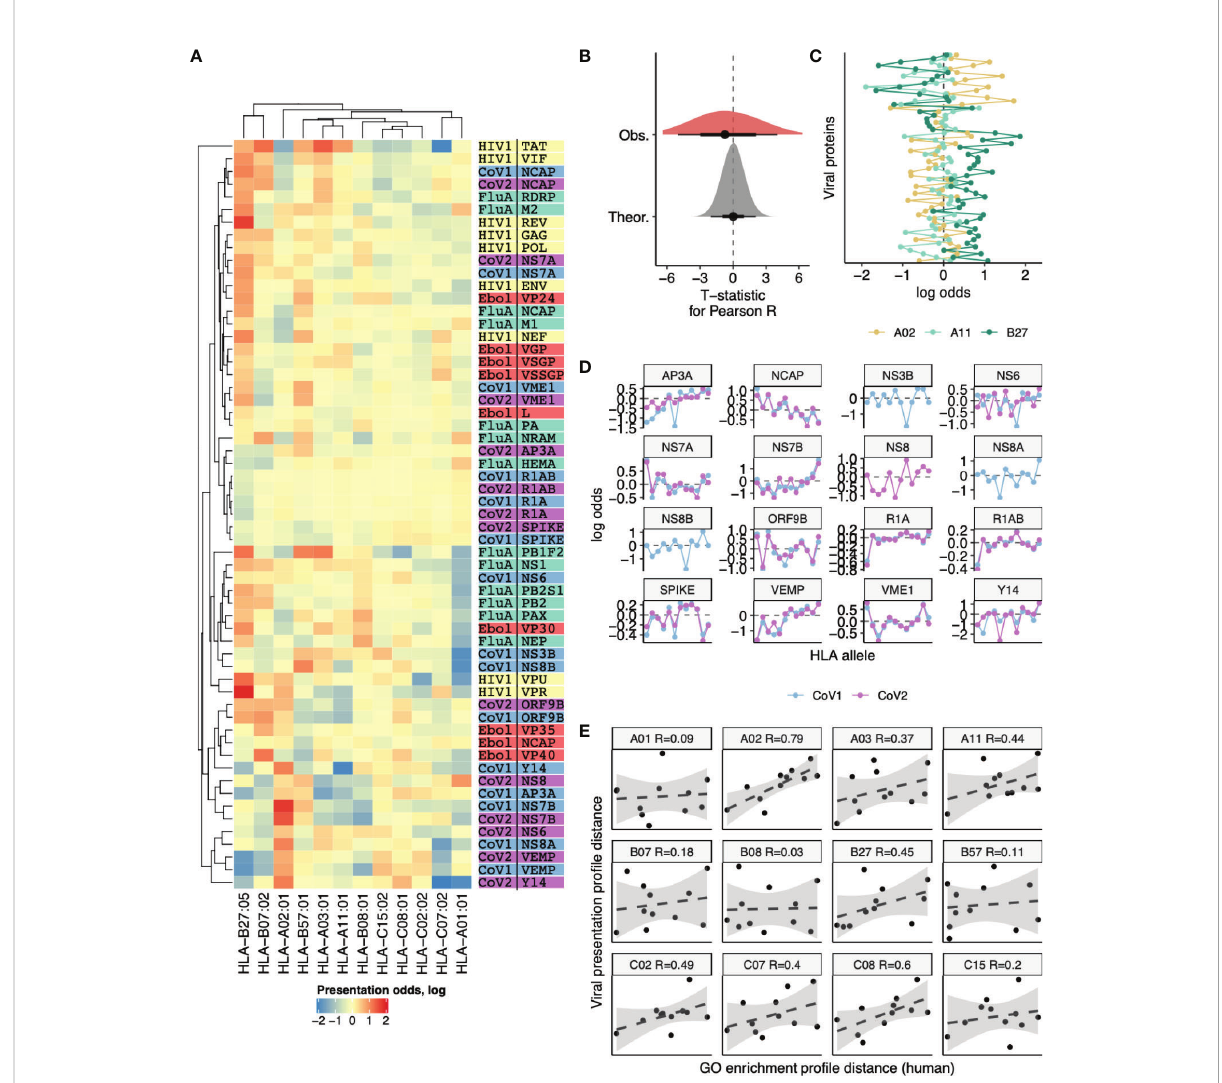
FIGURE 6 Differences in the number of ligands coming from viral genes presented by 12 different HLA alleles. (A) Heatmap showing the logarithm of the ratio of observed to expected number of HLA ligands (presentation odds). Expected number of ligands for each gene and HLA pair was estimated as the sum of corresponding row and column of the matrix divided by the total number of ligands in the matrix. Dendrograms show results of hierarchical clustering of gene-wise and HLA-wise presentation pro fi les performed using complete linkage algorithm with Euclidean distance measure. Proteins from HIV (yellow), In fl uenza (green), Ebola (red), SARS-CoV-1 (blue) and SARS-CoV-2 (purple) are shown. (B) Absolute values of T-statistic for observed pairwise correlation coef fi cients between viral gene presentation pro fi les of different HLAs (dark grey) compared to theoretical distribution (n=1000 random samples from null distribution with same number of degrees of freedom, light grey). (C) An example comparison of viral gene presentation pro fi les between HLA-A*02:01, HLA-A*11:01 and HLA-B*27:05 alleles. (D) Comparison of SARS-CoV-1 and SARS-CoV-2 protein presentation odds across different HLA alleles. (E) Correlation between distance in viral protein presentation odds pro fi les (Y axis) and distance in GO category pro fi les of HLA ligand-enriched human genes (X axis) for all HLA alleles. Each panel shows distances from a given HLA pro fi le to pro fi les of each of the remaining 11 HLA alleles. Allele name and Pearson correlation coef fi cient are shown in panel